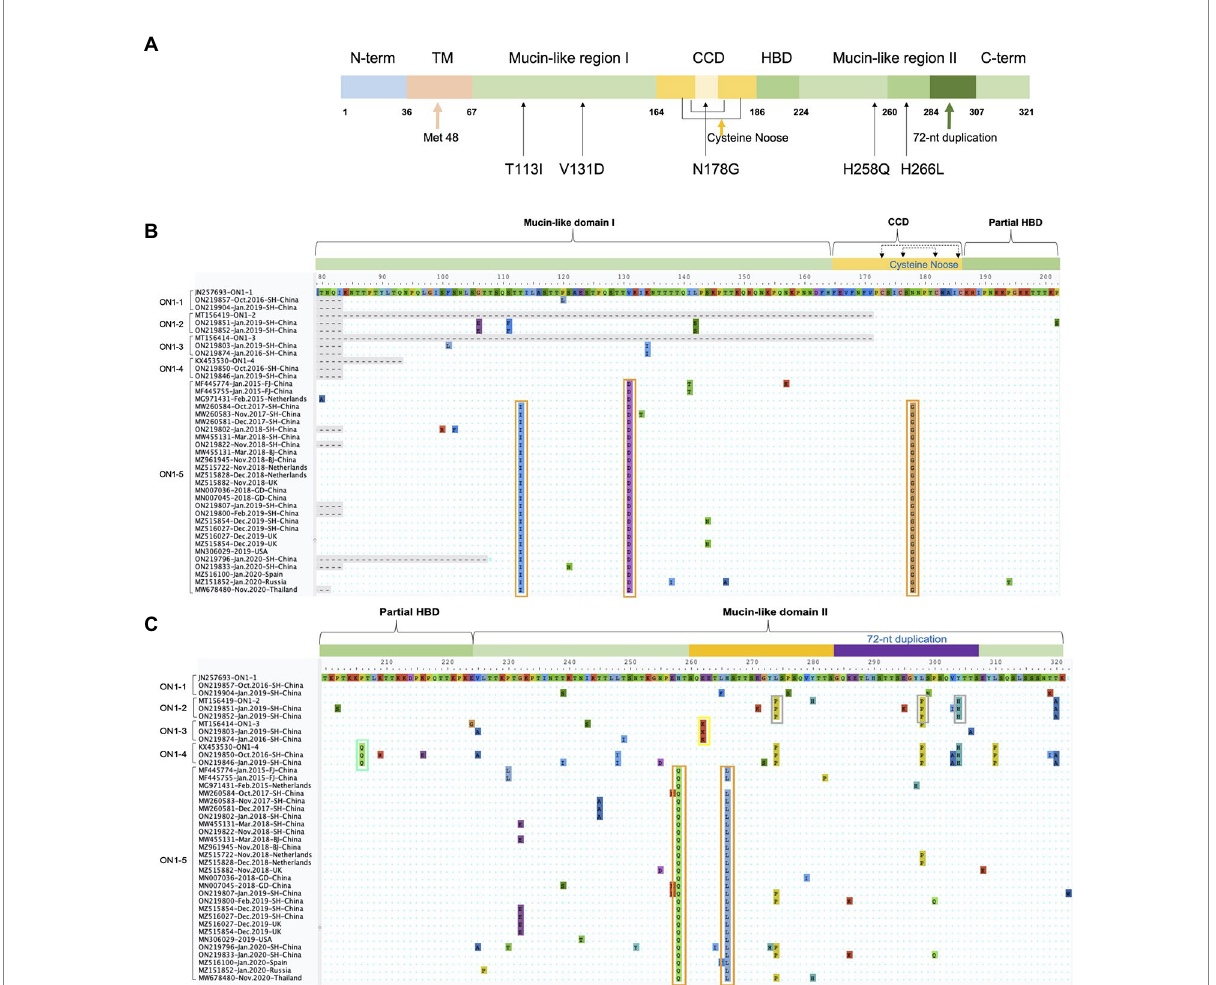
FIGURE 6 ON1-5-specific amino acid variations in G protein. (A) Schematic representation of ON1-5 G protein. Structural and functional features, as well as ON1-5-specific amino acid variations are shown. (B,C) Amino acid sequences of strains belonging to different ON1 lineages were aligned in MEGA, and regions containing lineage-specific variations are shown. Variations specific to each lineage are highlighted using colored